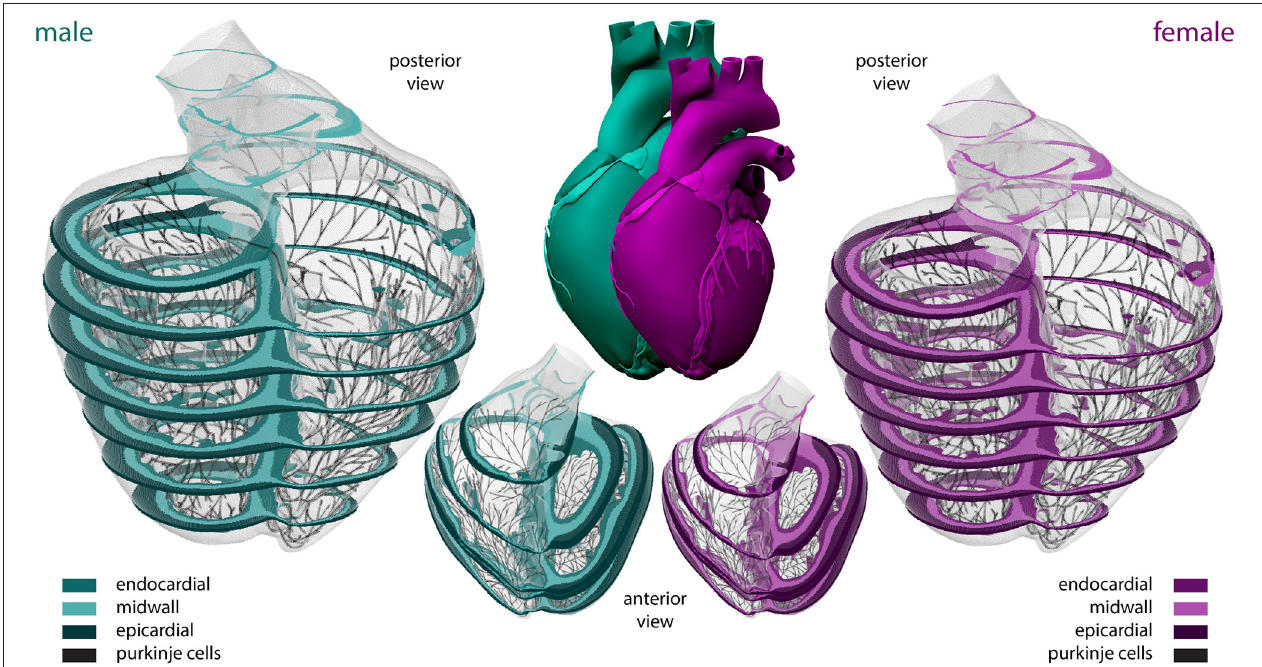
FIGURE 2 | Sex-specific multiscale exposure-response simulators . Male and female human heart model created from high resolution magnetic resonance images of a healthy male adult and isogeometrically scaled according to the average adult male/female ventricular mass ratio. The ventricular walls are discretized with 6,878,459 regular linear hexagonal finite elements. The Purkinje fiber networks are discretized with 39,772 linear cable elements and are connected to the ventricles at their terminals through 3,545 resistor elements. Endocardial, midwall, and epicardial cells are marked in median, light and dark green and purple, respectively; Purkinje cells are shown in black. Long-axis transmural slices are shown in the anterior view representations. Short-axis transmural slices are shown in the enlarged posterior